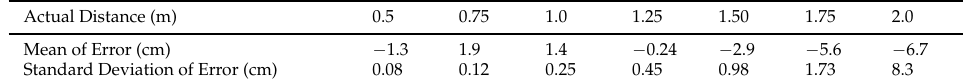
Table 3. Performance of the curve-fitting distance estimation approach.